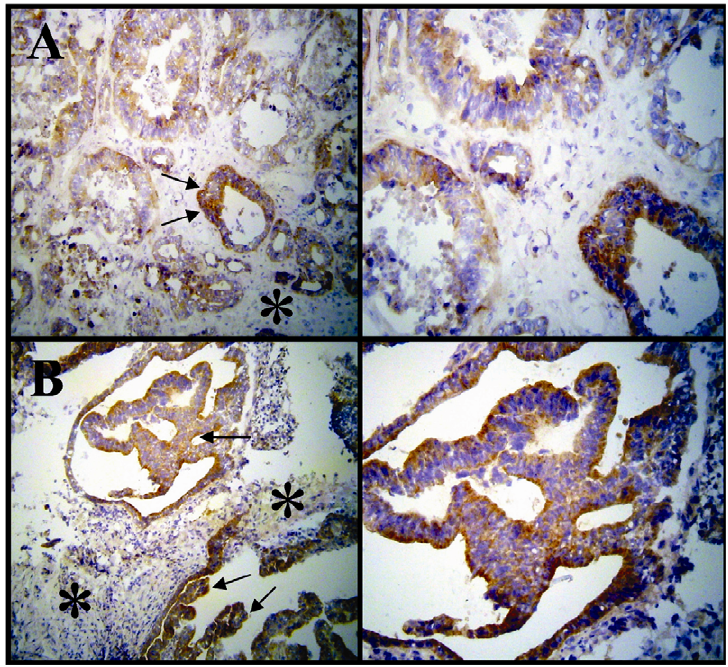
Fig. 1. Immunohistochemical staining of TNF- α . Representative images of immunohistochemical expression of TNF- α by tumor cells during tumor progression (cytoplasmic staining pattern, brown, arrows). TNF- α is increased on tumor cells in early stage tumors (UICC I/II) (A). In advanced stage tumors (UICC III/IV) TNF- α expression is increased compared to early stage tumors (UICC I/II) (B). Adjacent stromal cells (asterisks) stained negative for TNF- α . DAB brown color, Haemalaun blue color, nuclear counterstaining. Original magnification: left × 100, right × 200. (The colors are visible in the online version of the article;